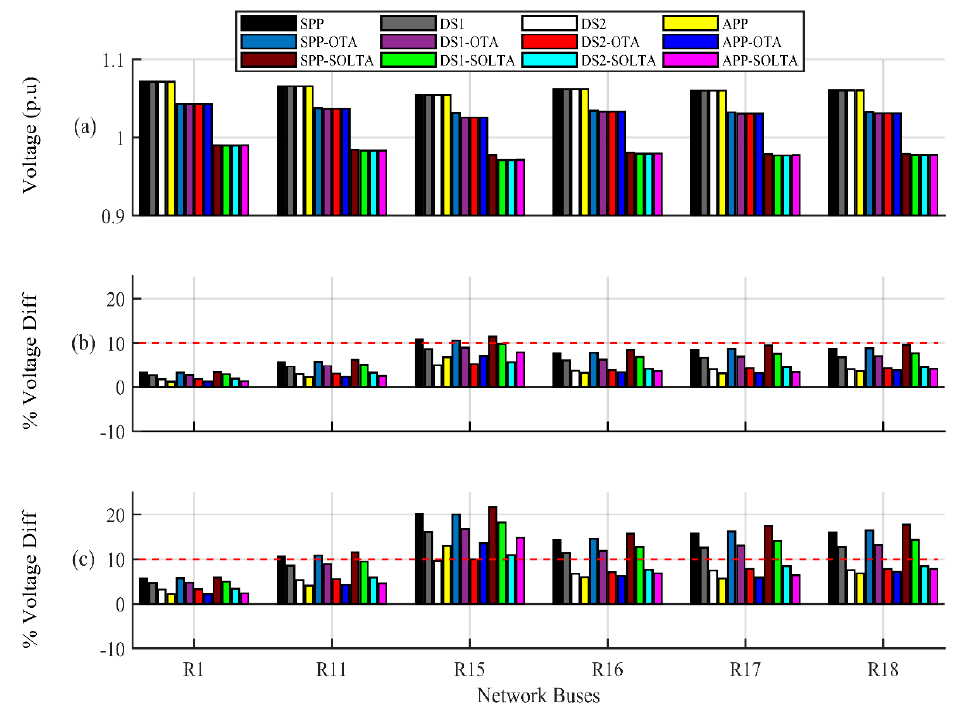
Figure 5. Voltage magnitude and percentage voltage di ff erence at distribution network buses with PV penetration levels: ( a ) voltage at 0% PV; ( b ) percentage voltage di ff erence at 30% PV; ( c ) percentage voltage di ff erence at 60% PV .